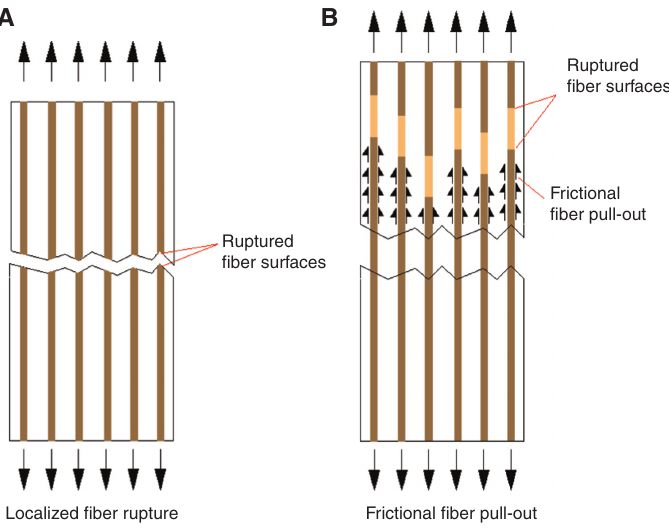
Figure 1 Local and distributed yielding of the matrix in composite.